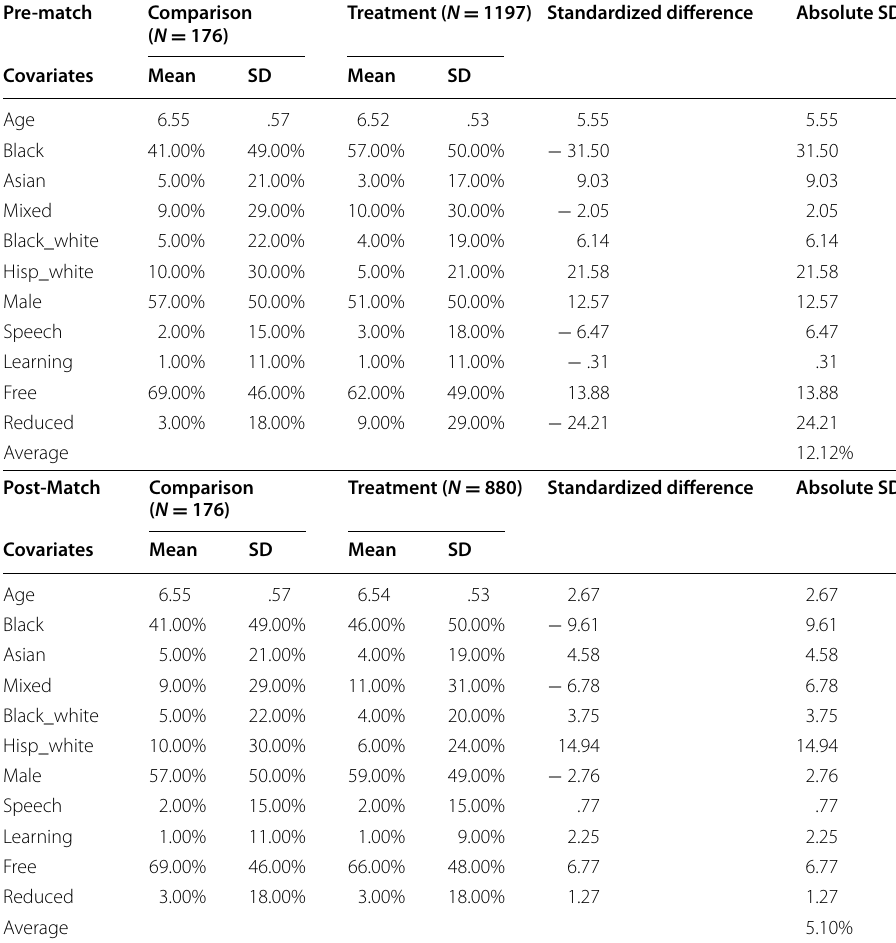
Table 1 Pre/post-match balance